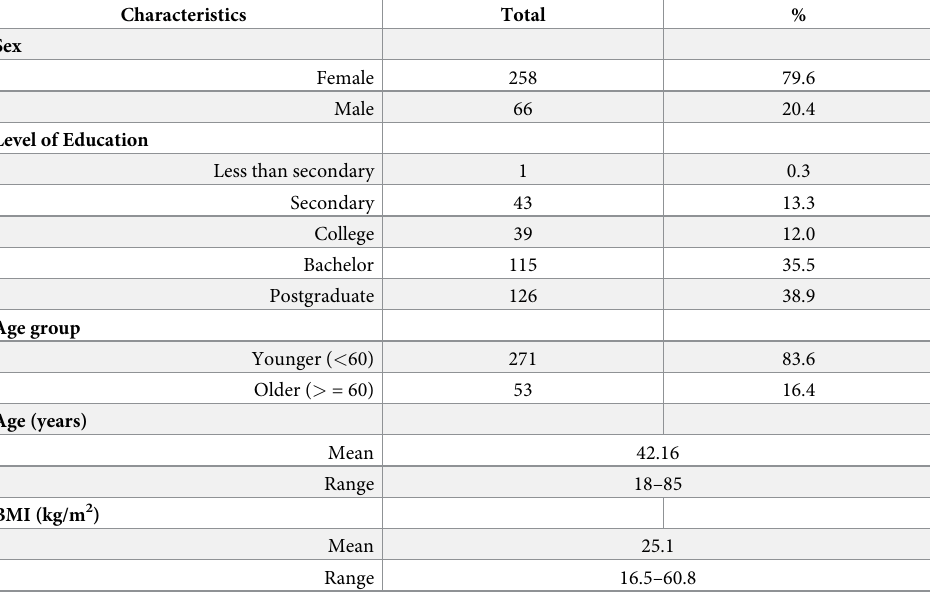
Table 1. Demographic characteristics of the participants (n = 324) who completed the EatWellUK baseline